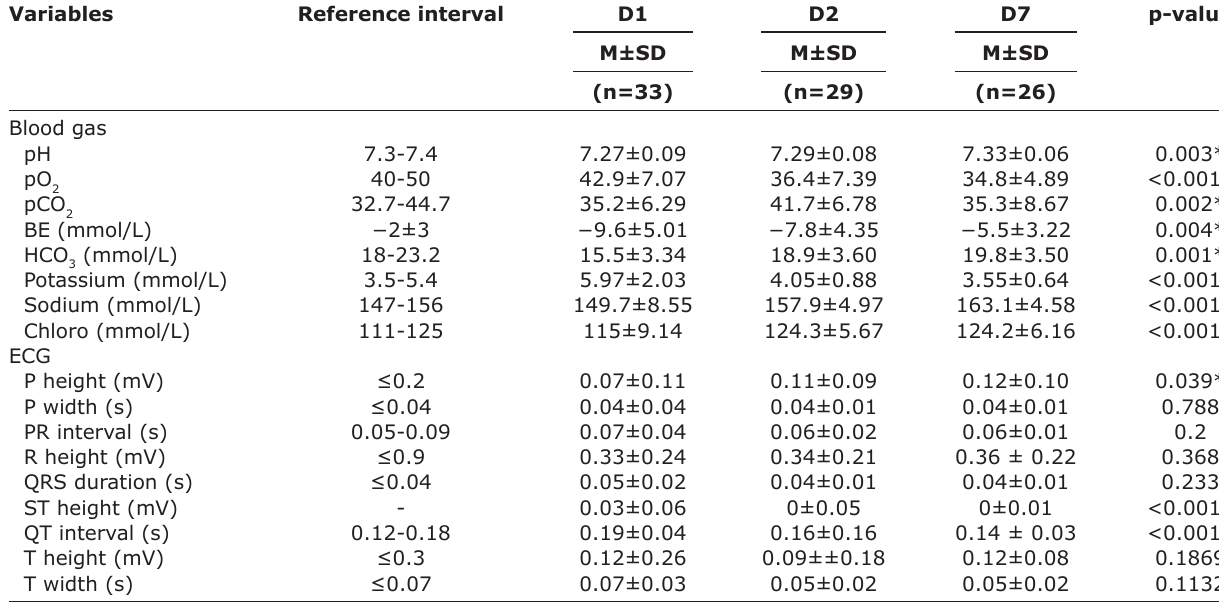
Table-2: Descriptive statistics and univariate analysis of feline blood gas analysis and ECG with UO at times D1, D2, and D7.